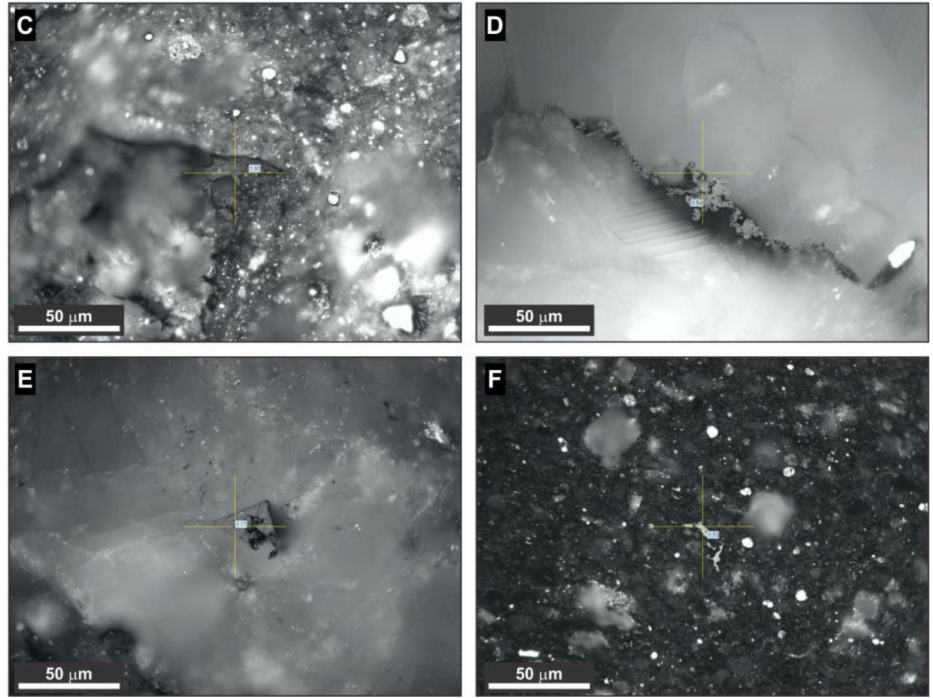
Figure 7. ( A – F ) Photomicrographs of solid bitumen C in whole-rock polished blocks under reflected white